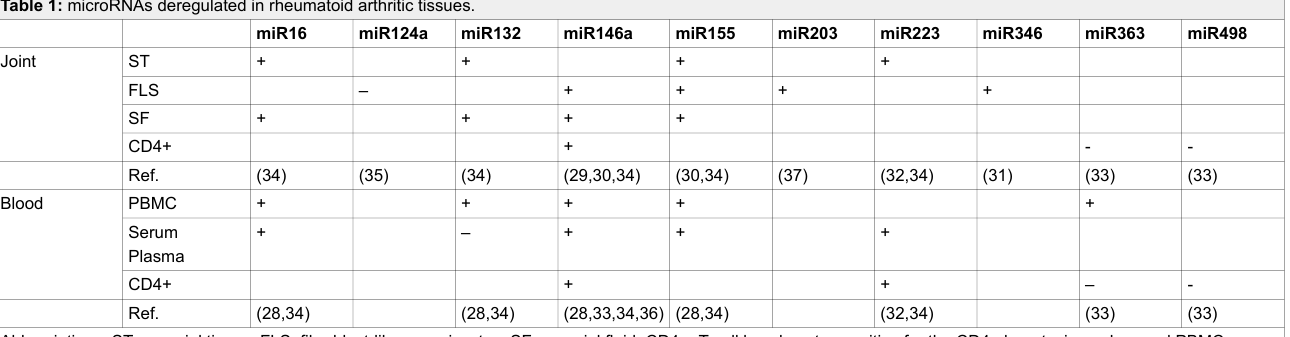
Abbreviations: ST, synovial tissue; FLS, fibroblast-like synoviocytes; SF, synovial fluid; CD4+, T cell lymphocytes positive for the CD4 phenotypic marker; and PBMC, peripheral blood mononuclear cells. (+) increased or (-) decreased expression